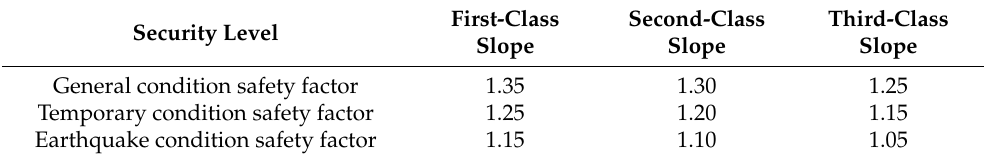
Table 5. Slope stability safety